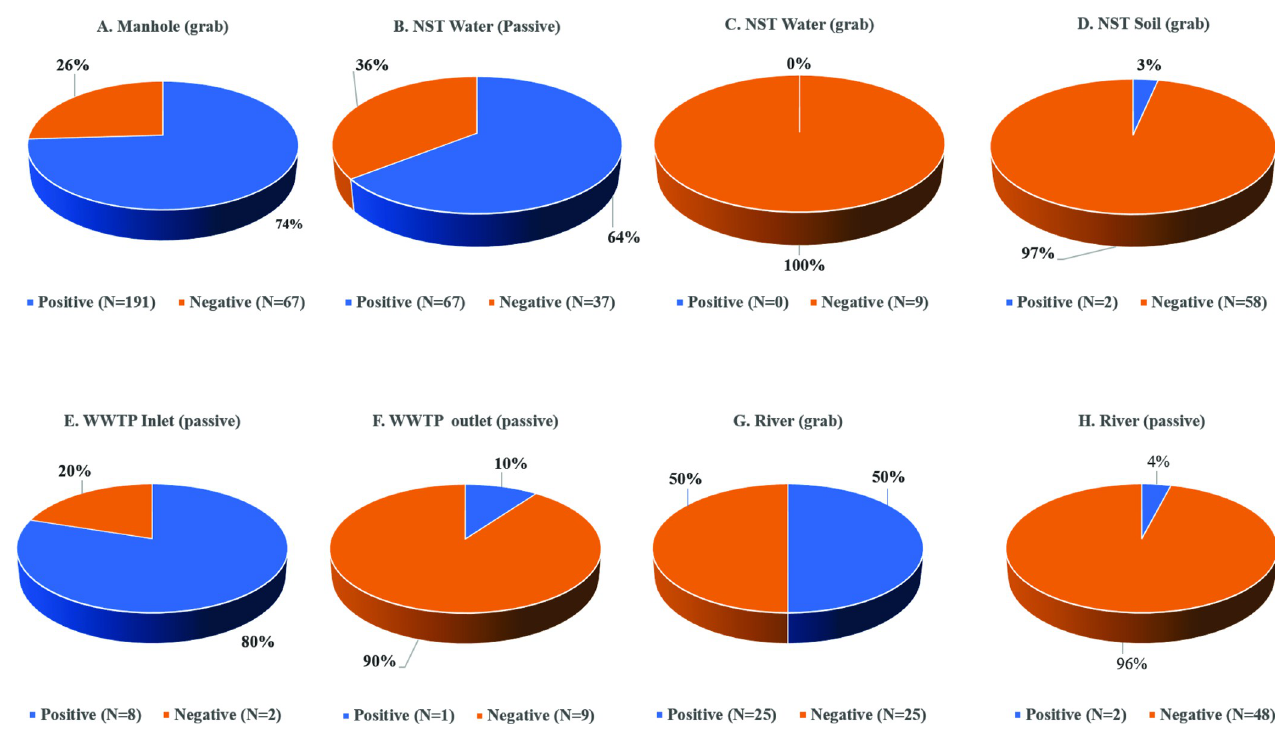
Fig 2. Nucleocapsid (N) gene positivity by sample